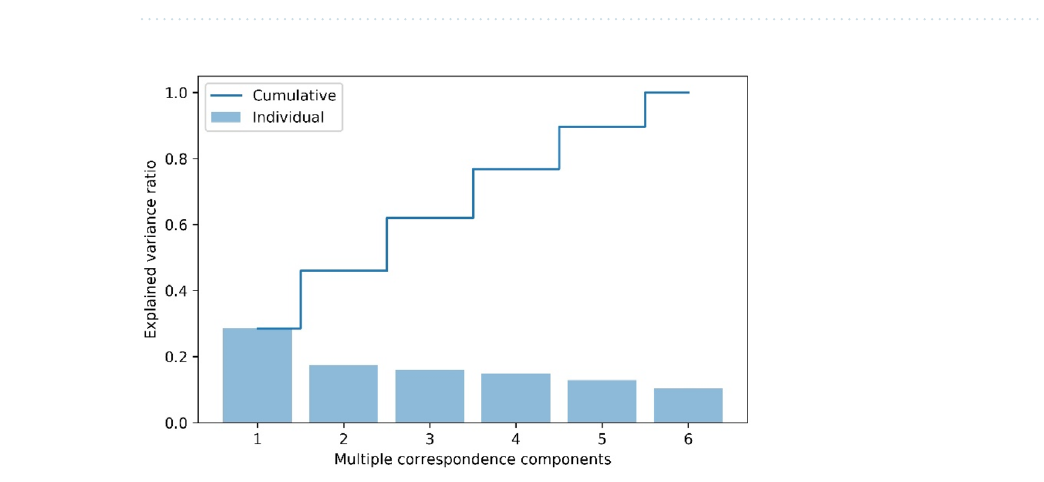
Table 3. Characteristic distribution of OCT biomarkers in PCV and nAMD subjects. This table revealed the characteristic distribution of OCT biomarkers in nAMD and PCV group.